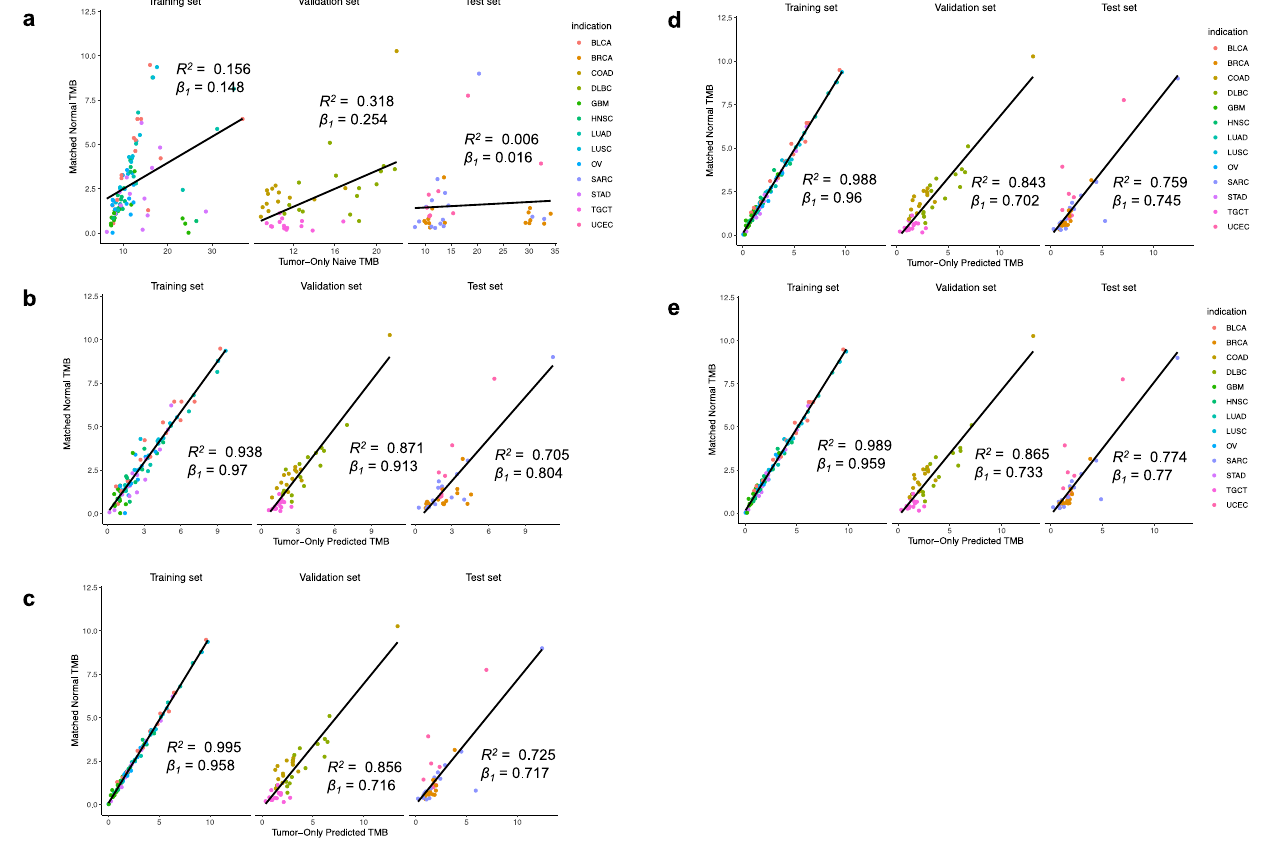
Fig. 3 Concordance of tumor-mutational burden calculated with and without matched normals. Training set, n = 105; Validation set, n = 45; Test set, n = 45 patients. a Matched-normal TMB compared to TMB estimated by the naive tumor-only approach — variants are fi ltered by removing common germline variants using multiple population germline databases and a process-matched leave-one-out panel of normals. b – e Matched-normal ( ” true ” ) TMB compared to TMB estimated with somatic mutation classi fi cation via b TabNet, c XGBoost, d LightGBM, and e ensemble average of all three models β 1 indicates the slope of linear regression fi